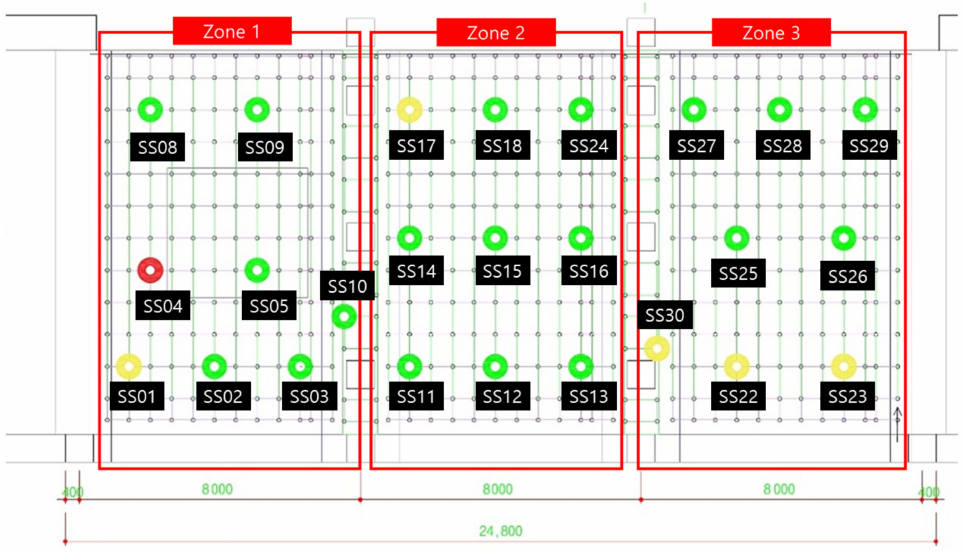
Figure 25. Load-monitoring screen